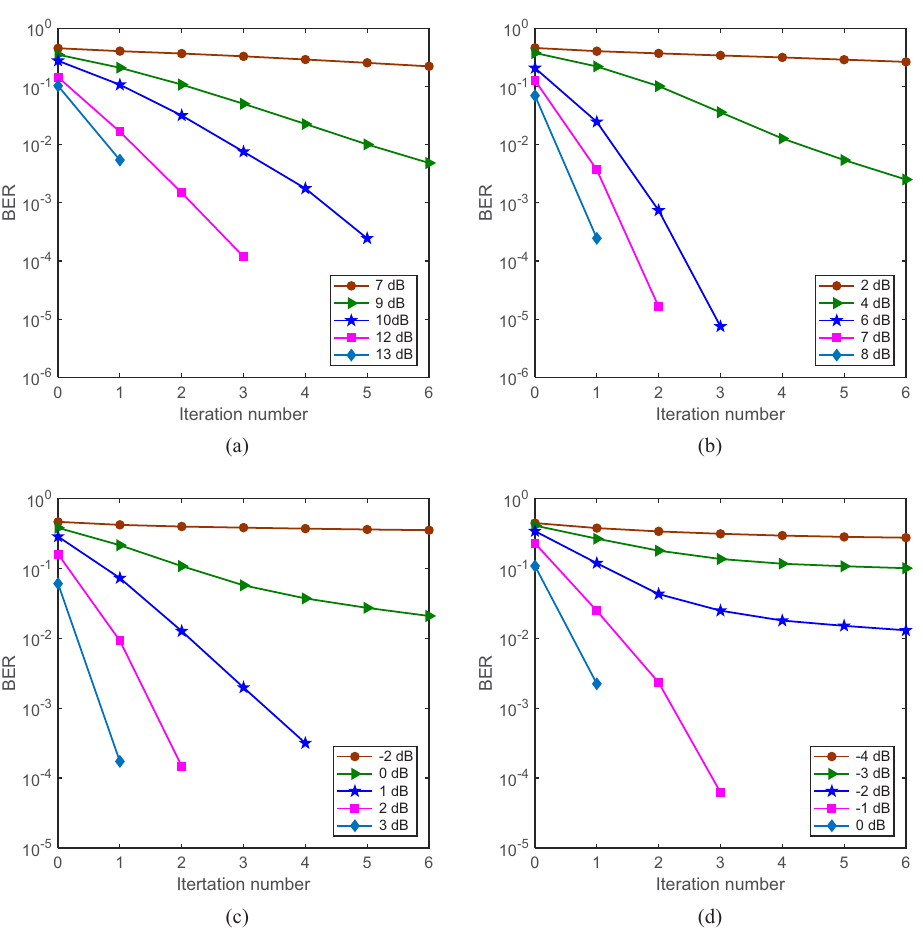
Figure 7. BER performance for S256. ( a ) Rate-1/2 convolutional code; ( b ) rate-1/4 convolutional code; ( c ) rate-1/8 convolutional code; ( d ) rate-1/16 convolutional code.